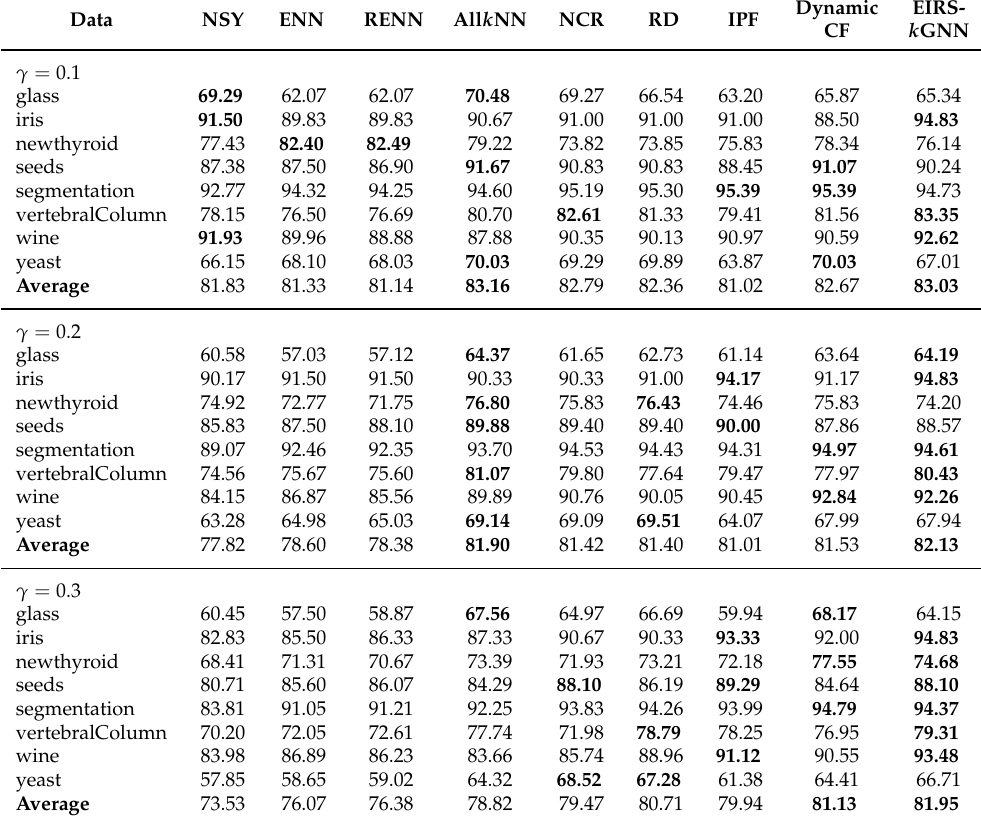
Table 7. Average macro-AUC comparison (%) of classification results at varying γ . Data NSY ENN